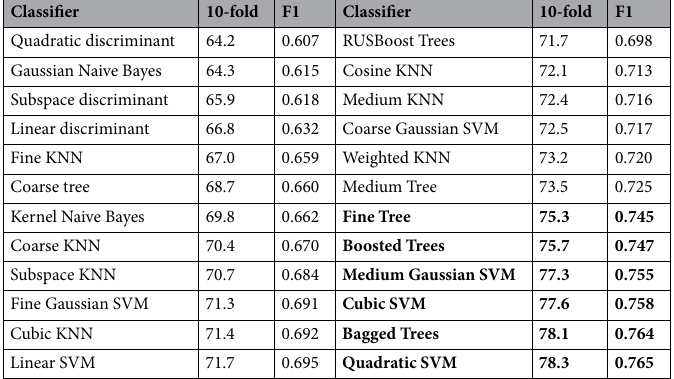
Table 3. Performance of classifiers [%]. Classifiers used in majority voting are in